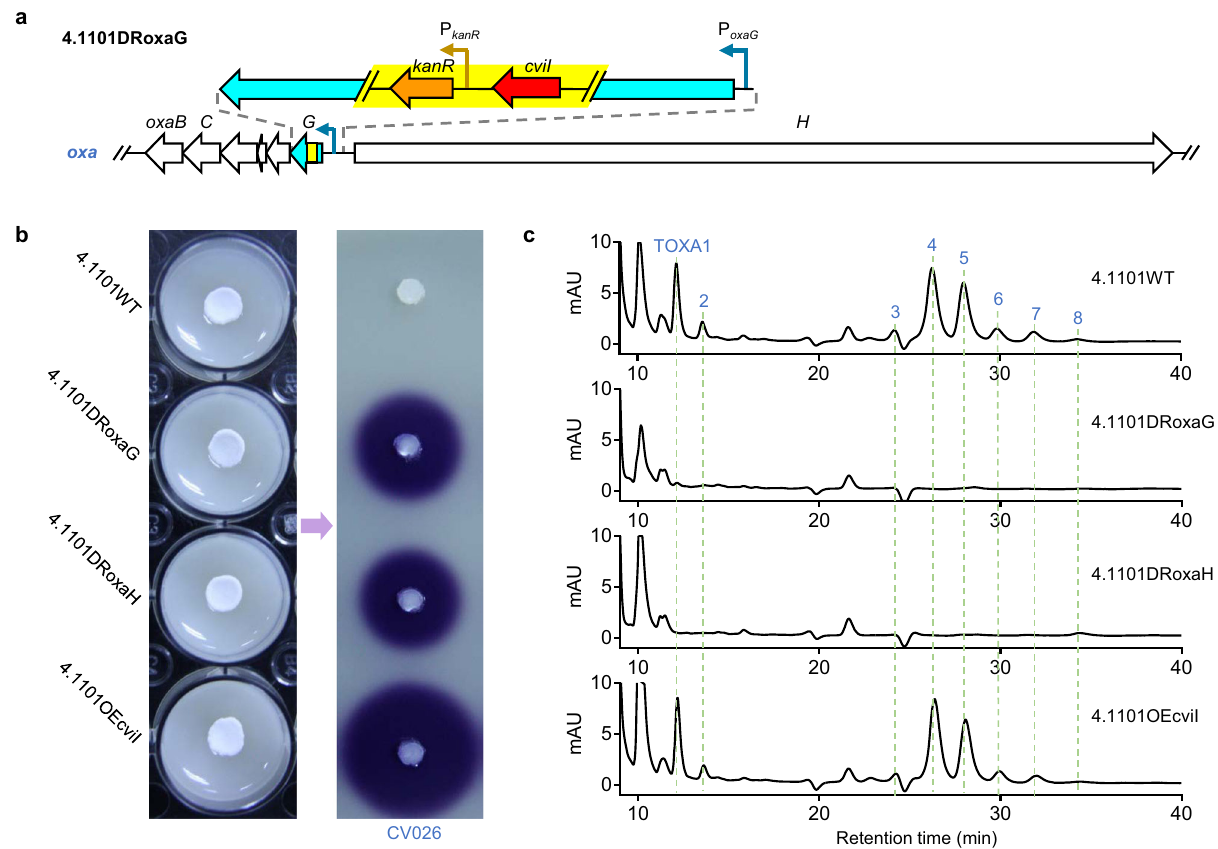
Fig. 4 Construction and evaluation of dual-functional reporter strains for oxa . a Construction of the dual-functional reporter strains. Taking 4.1101DRoxaG as an example, cviI (reporter gene) and kanR (kanamycin resistance gene, the selection marker) were ligated as a reporter gene cassette to replace part of the key coding region of oxaG via homologous recombination to generate dual-functional reporter strain 4.1101DRoxaG. Another reporter strain 4.1101DRoxaH was constructed similarly. b cviI expression analyses of 4.1101DRoxaG and 4.1101DRoxaH grown on MS agar medium in 12-well plates by agar plug assays. 4.1101WT (the wild-type strain of S. longshengensis CGMCC 4.1101) and 4.1101OEcviI (a derivative strain of 4.1101WT containing cviI overexpression plasmid driven by P hrdB on pIJ10500K) were used as negative and positive control, respectively. c The production of TOXAs in the above four strains grown on MS agar medium. The differential chromatographic peaks of 4.1101WT and 4.1101OEcviI compared with the reporter strains are indicated by dashed lines, and the corresponding compounds were named as TOXA1-TOXA8, respectively. Data shown in b and c are representative of two independent experiments that displayed similar